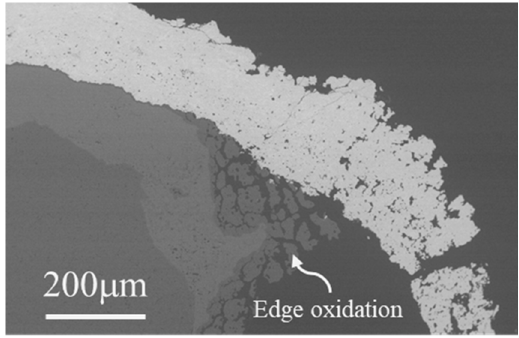
Figure 13. SEM image of LPPS EBCs coating edge after 1000 steam cycles.